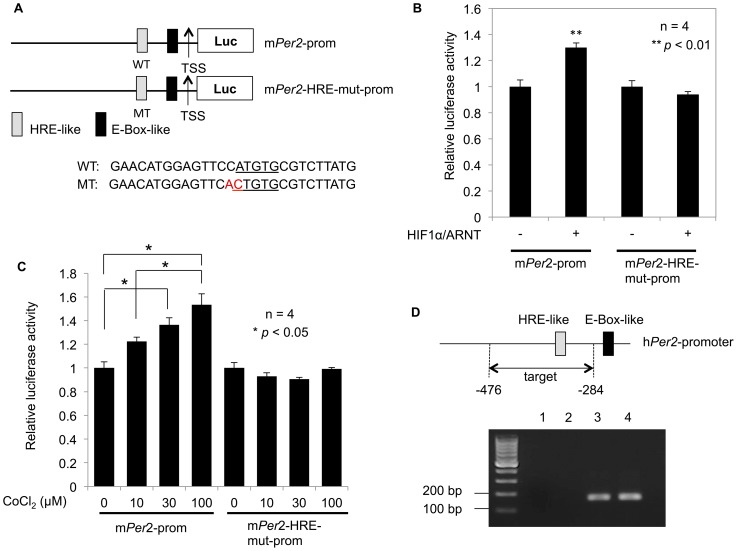
The effects of HIF1α/ARNT on the Per2 promoter.(A) Schematic representation of the mouse Per2 promoter. The upper area represents the wild-type mouse Per2 promoter and the lower area represents the HRE-mutant Per2 promoter. (B) HIF1α/ARNT potently induced Per2 promoter activity. The Per2 promoter and the HRE-mutant Per2 promoter reporter (60 ng) were co-transfected with the indicated expression plasmids (+; 50 ng). Per2 promoter activities were significantly increased (mean ± SEM, n = 4, p<0.01, Student's t test) compared to the control (without the expression plasmid), but the HRE-mutant Per2 promoter was not affected. (C) Twenty-four hours after treatment with CoCl2 (10, 30, 100 µM for 6 h), luciferase activity was measured. Per2 promoter activities were significantly increased (mean ± SEM, n = 4, p<0.05, one-way ANOVA followed by Tukey's post hoc tests) concentration-dependently compared to the control, but the HRE-mutant Per2 promoter was not affected. (D) HIF1α specifically interacts with the HRE-like sequence within the Per2 promoter. Caki-2 cells were cross-linked, lysed, and immunoprecipitated with anti-HIF1α antibody or normal rabbit IgG (negative control). The precipitated DNA was subjected to PCR with primers specific for the target region (−476/−284). One aliquot of input DNA was used as a positive control. PCR product was observed in the anti-HIF1α ChIP (lane 3) and 10% Input DNA (lane 4). Substantially less was detected in the no antibody ChIP (lane 1) and normal rabbit IgG ChIP (lane 2) lanes.